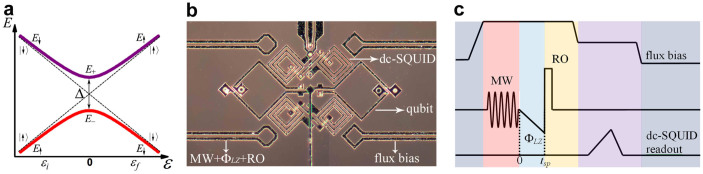
Circuit and experimental procedure.(a) A general avoided energy-level crossing with diabatic basis states (the dashed lines) and adiabatic basis states (the solid lines). The constant gap Δ between the two instantaneous eigenenergy states at ε = 0 is the tunneling amplitude, i.e., the coupling strength. (b) Optical micrograph of the sample with Al/AlOx/Al Josephson junctions on the silicon substrate. MW, ΦLZ and RO represent the microwave pulse to prepare the initial state, the sweeping flux bias to induce LZT and the 5-ns flux bias pulse to tilt the potential well in order to readout the qubit state, respectively. The planar coils and dc-SQUID magnetometer are coupled inductively to the qubit. (c) A typical time profile of the manipulation and measurement waveforms employed to perform the single-passage Landau-Zener experiment.